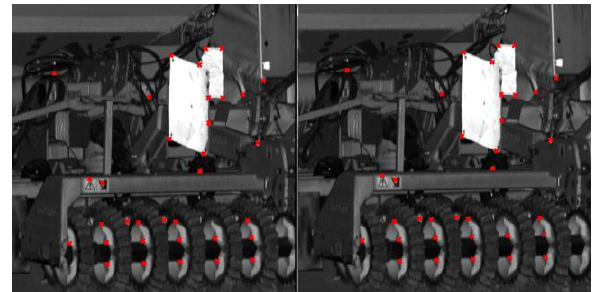
Figure 2. Fractions of the intensity images of 1 segment pair belonging to the 1 st scan (left) and the 2 nd scan (right) of the two-face measurements (red crosses – matched keypoints).